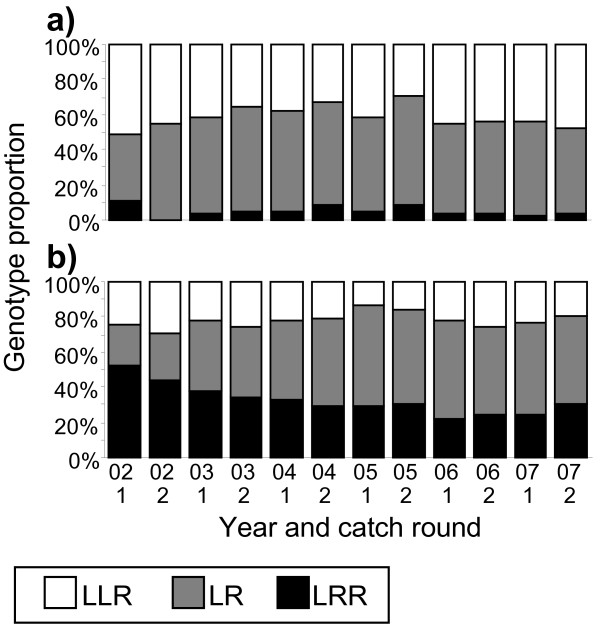
Temporal development of genotype proportions summed over the 12 Swedish ponds. a) males and b) females. The ponds were sampled twice per year from 2002 to 2007.